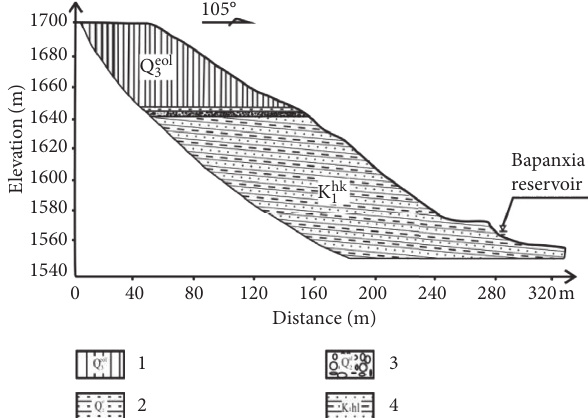
Figure 9: Engineering geological profile of landslide (1: loess; 2: silty clay; 3: sand and gravel; and 4: sandy mudstone